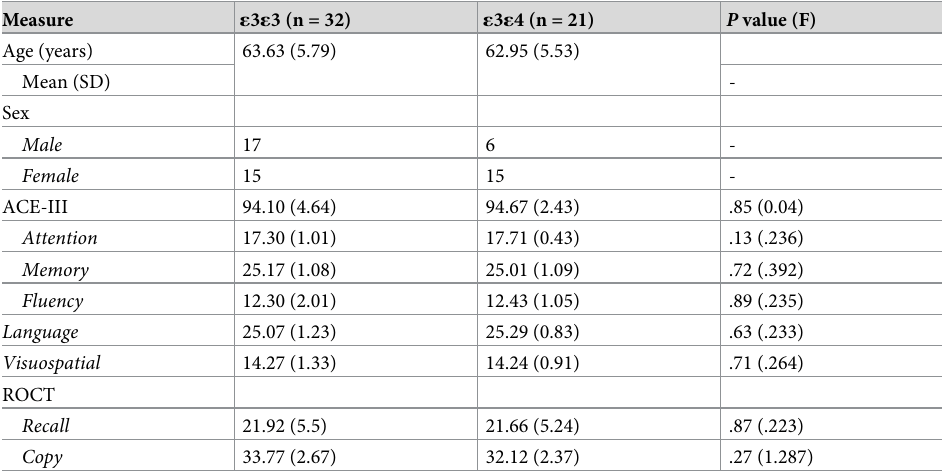
Table 3. Primary demographic and neuropsychology characteristics of the sample.